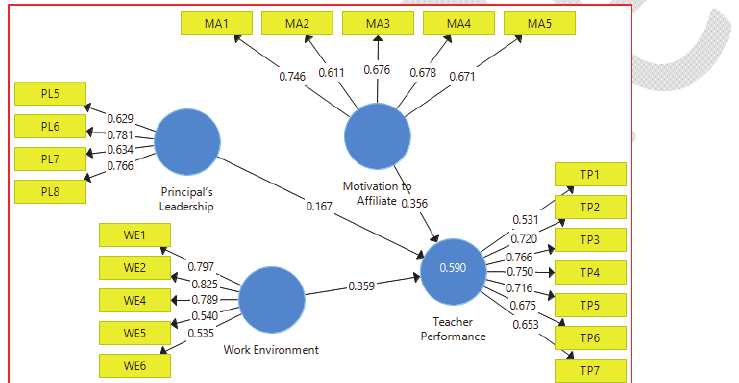
Fig. 3. Measurement Model